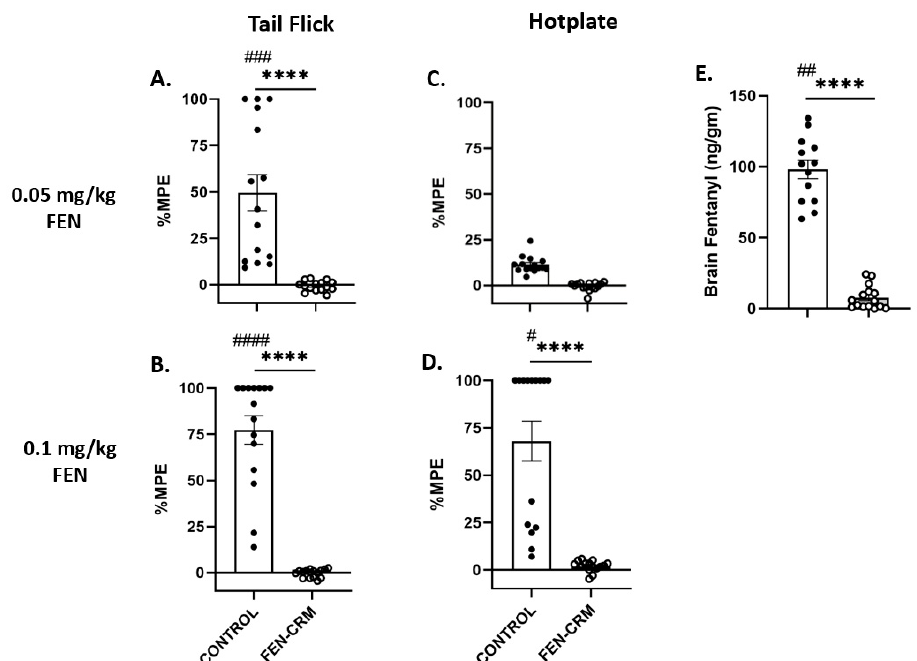
Figure 2. Vaccine efficacy against FEN-induced anti-nociception and FEN distribution in male Sprague Dawley rats. Rats were vaccinated with PBS (CONTROL, open bars, N = 15) or (FEN-CRM, gray bars, N = 15) at day 0, then boosted at 3 and 6 weeks. At 8–12 weeks post initial vaccination, rats were administered one of two doses of FEN (0.05 mg/kg and 0.1 mg/kg, SC) then tested in the tail flick ( A , B ) and hotplate ( C , D ) nociception assays. Data are presented as mean ± SEM %MPE (Maximal Possible Effect). Vaccinated rats showed no response to FEN-induced analgesia in the tail flick and hotplate assays whereas unvaccinated rats showed robust analgesic effects with the high FEN dose. Brain ( E ) FEN levels were obtained following administration of FEN (0.1 mg/kg, SC) at approximately week 20 post initial vaccination in the same rats. FEN was prevented from penetrating the brain in vaccinated rats but not in unvaccinated rats. **** p < 0.0001; CONTROL male vs. CONTROL female groups: # p < 0.05, ## p < 0.01, ### p < 0.001, #### p <